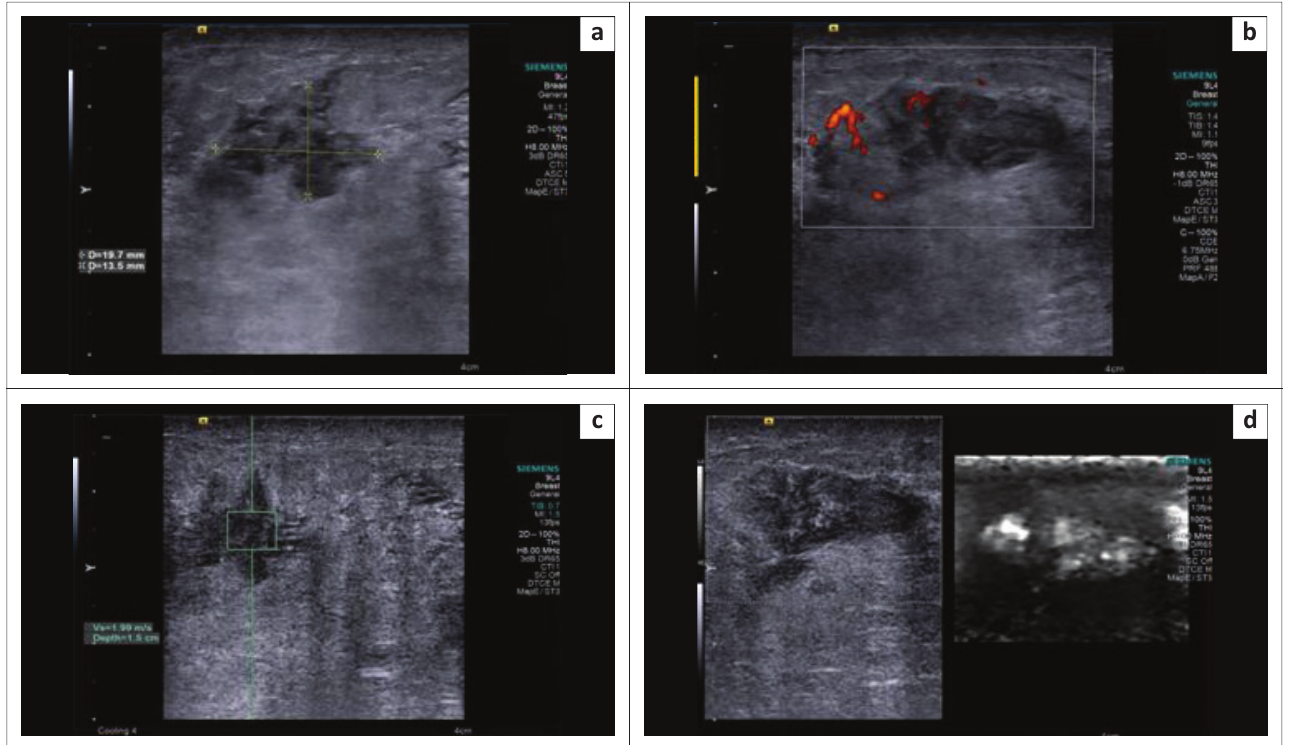
FIGURE 2: (a) B-mode ultrasonography image indicating an irregular, isoechoic spiculated lesion suggesting a Breast Imaging Reporting and Data System 4 lesion; (b) on power Doppler, the lesion demonstrates internal vascularity; (c) shear wave velocity in the lesion was 1.99 m/s; (d) the lesion appeared bright on virtual touch imaging elastogram, suggestive of a soft lesion. The final histopathology report was granulomatous